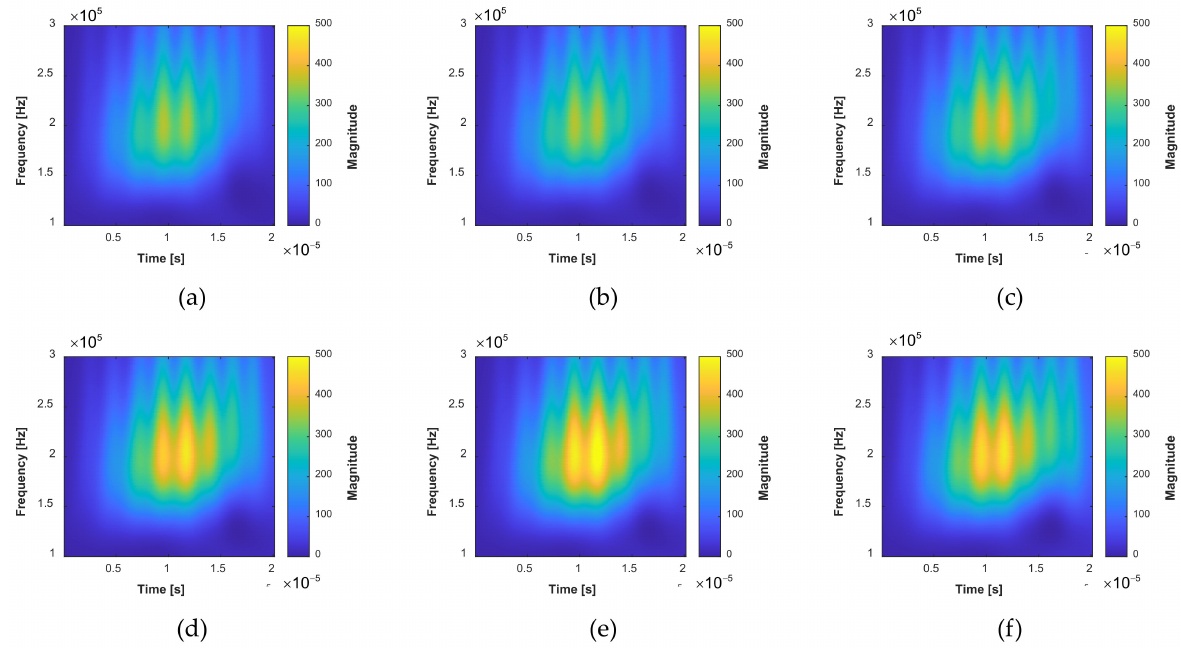
Figure 10. Extracted TFS images with the fatigue crack growth in specimen D1: ( a ) The TFS image of the GW signal collected when the total crack length is 0 mm obtained by the continuous wavelet transform; ( b ) The total crack length is 4.2 mm; ( c ) The total crack length is 9.5 mm; ( d ) The total crack length is 16 mm; ( e ) The total crack length is 22 mm; ( f ) The total crack length is 32